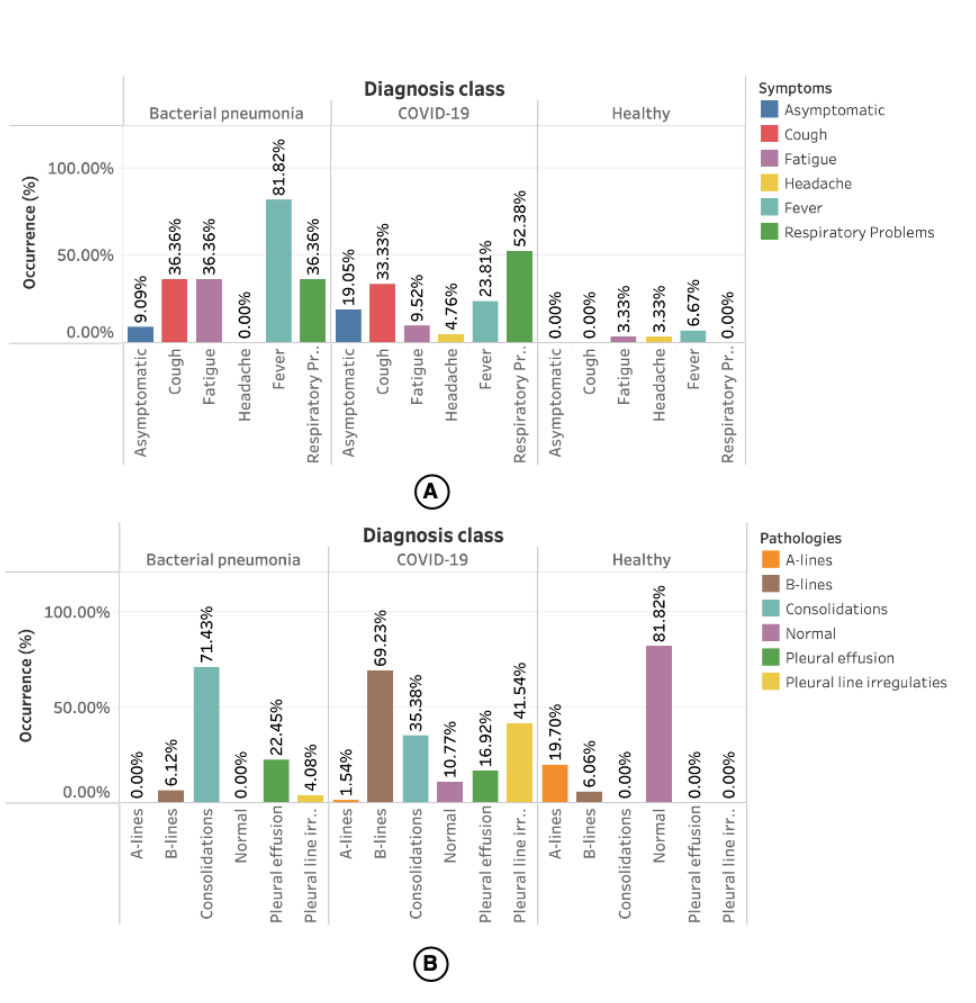
Figure 5. ( A ) shows the occurrence of symptoms in the LUS videos segmented by diagnosis class. ( B ) shows the occurrence of pathologies segmented by diagnosis